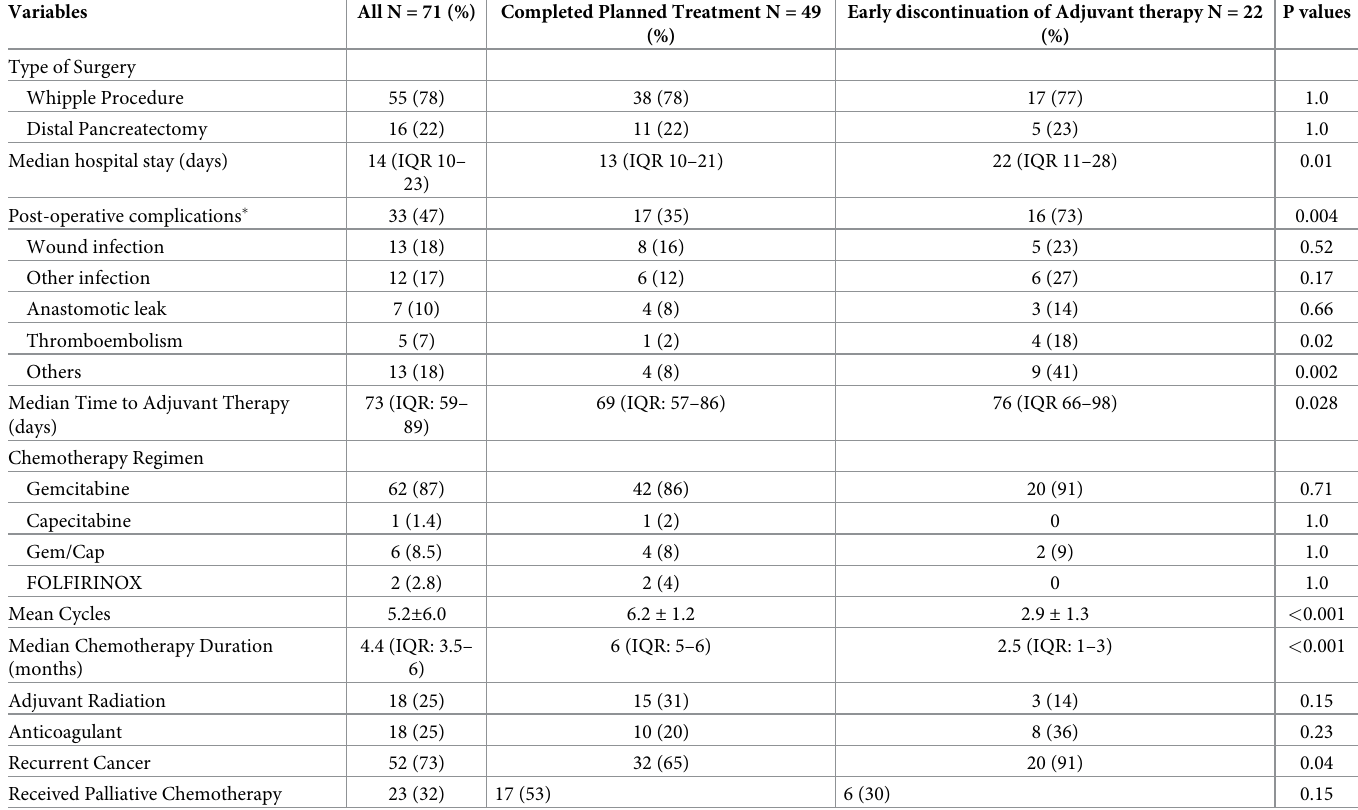
Table 2. Interventions and various outcomes in the two groups of patients with early stage pancreatic cancer. Variables